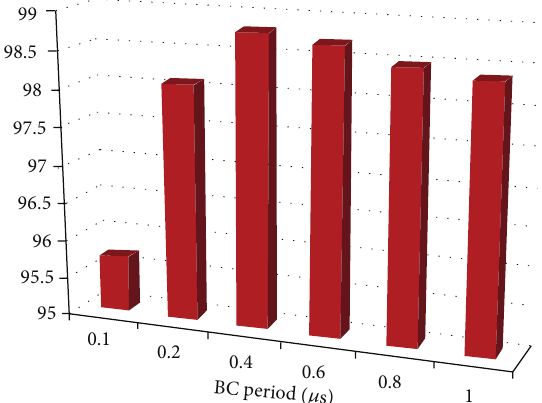
Figure 25: Freezing efficiency plot for the whole matrix. Efficiency drop at 100ns is caused by scan buffer overflows. On vertical axis we have efficiency expressed in